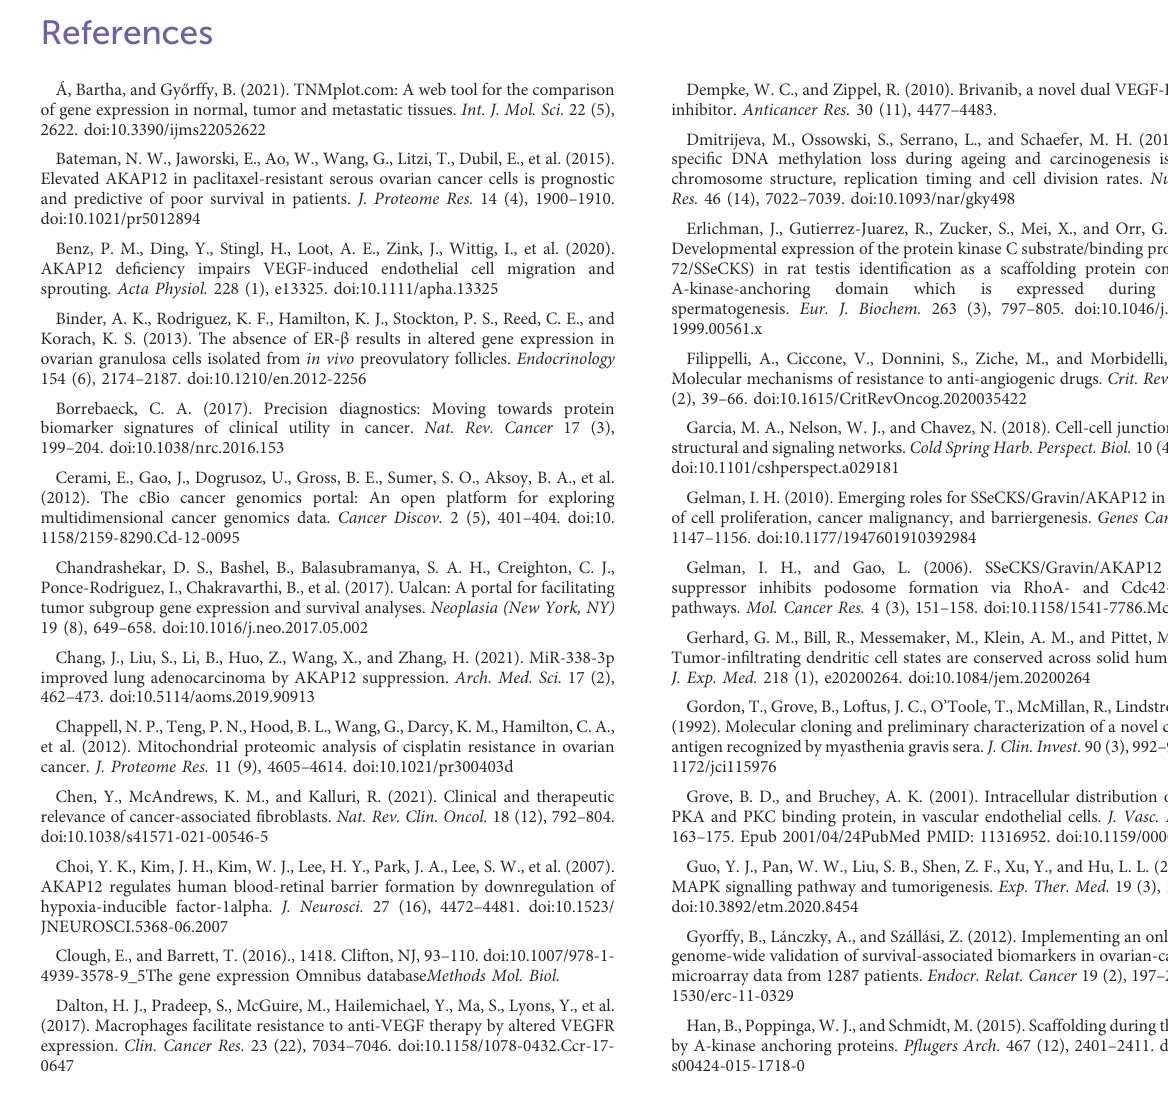
corresponding normal tissues (GTEx database) based on GEPIA2. (C) Total protein levels of AKAP12 in normal tissues and primary breast cancer, colon cancer, HNSC, HCC, LUAD, OV, and UCEC. Protein data were acquired and analyzed by applying CPTAC. (D) Comparison of AKAP12 mRNA expression between normal and cancerous tissues and immunohistochemistry images in normal and cancerous tissues. AKAP12 protein expression was signi fi cantly lower in BRCA, COAD, UCEC, and OV. SUPPLEMENTARY FIGURE S5 DNA methylation and protein phosphorylation analysis of AKAP12 in multiple cancers based on the Ualcan database (A) . Comparison of the level of AKAP12 methylation between primary tumor tissues versus normal tissues. (B) Phosphoprotein sites with a statistical difference in AKAP12 are schematically depicted in a diagram. (C) Box plot representation of AKAP12 phosphoprotein levels in BRCA, KIRC, and LUAD. SUPPLEMENTARY FIGURE S6 The correlation between the AKAP12 expression and in fi ltration of B cells (A) , NK cells (B) , CD8+ cells (C) , and Treg cells (D) among all TCGA tumors according to EPIC, MCPCOUNTER, TIDE, XCELL,